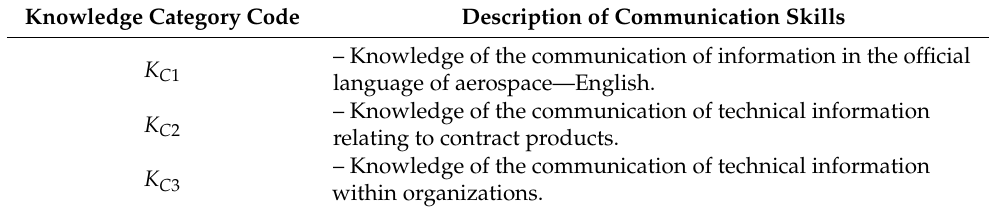
Table 11. List of communication